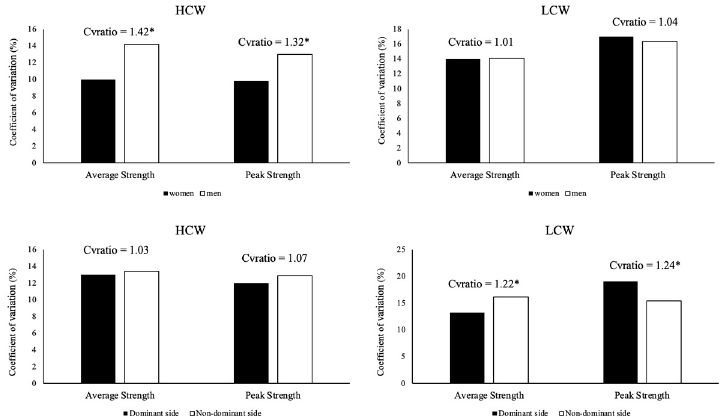
Figure 3. Comparison of the reliability of the outcomes of the average and peak strength of the trunk rotator relationship between women and men in the low cable woodchop exercise and the horizontal cable woodchop exercise ( upper panel ) and the average and peak strength of the trunk rotator relationship between the dominant and non-dominant sides in the low cable woodchop exercise and the horizontal cable woodchop exercise ( lower panel ). * Meaningful differences in reliability were identified by a CVratio higher than 1.15.